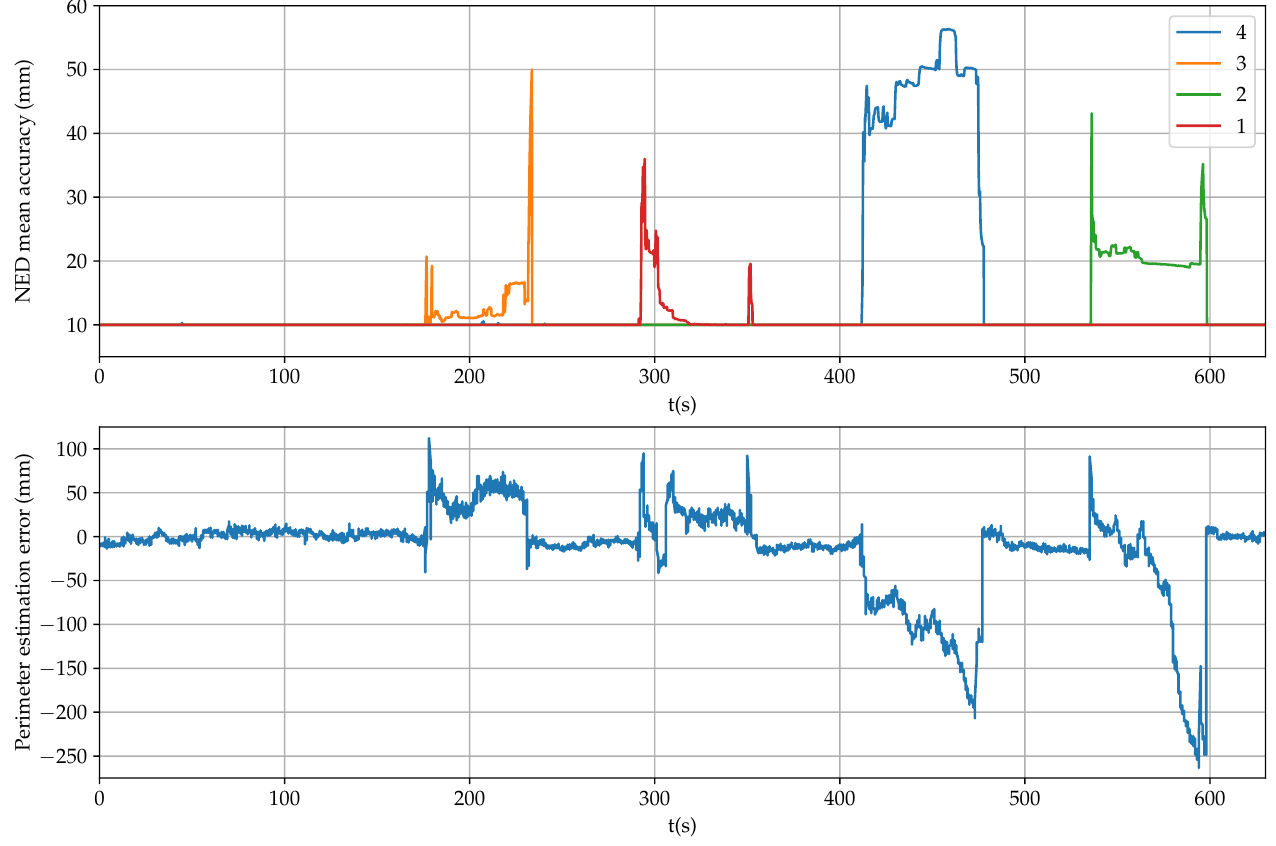
Figure 10. Accuracy estimation during the reliability